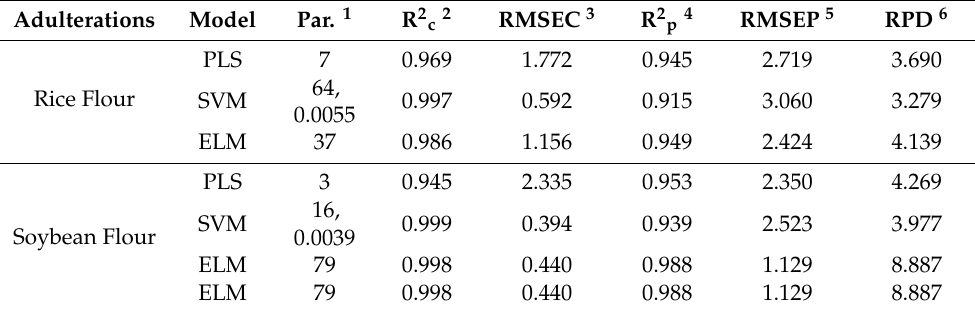
Table 5. Results of determination of adulterations content in milk using full spectra.